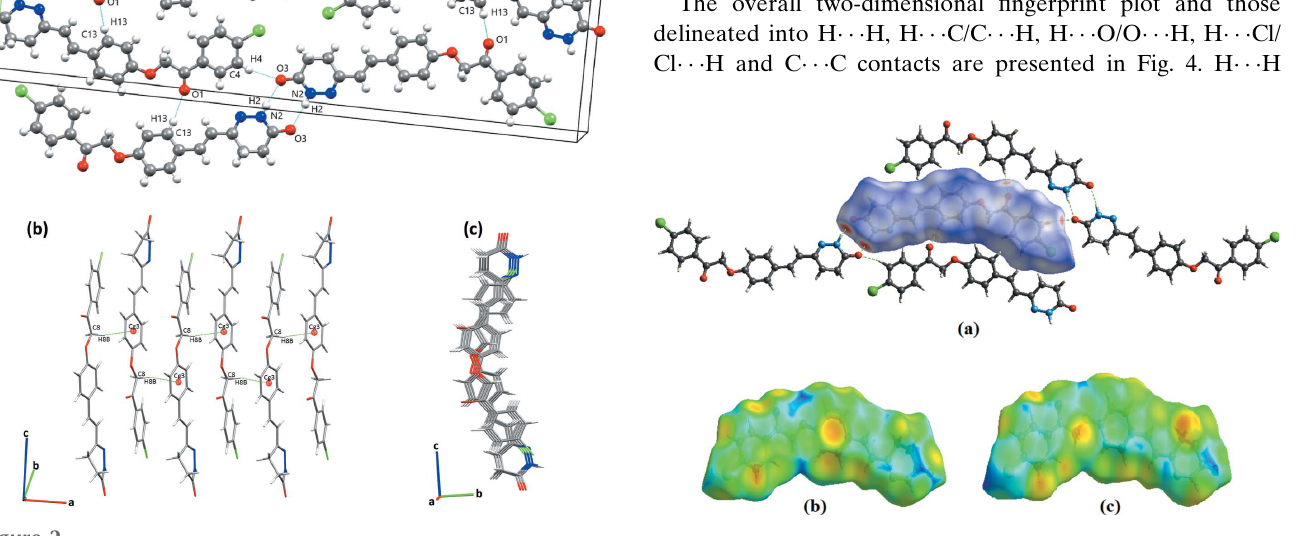
(Table 2). The surfaces mapped over d Fig. 3 b and 3 c .